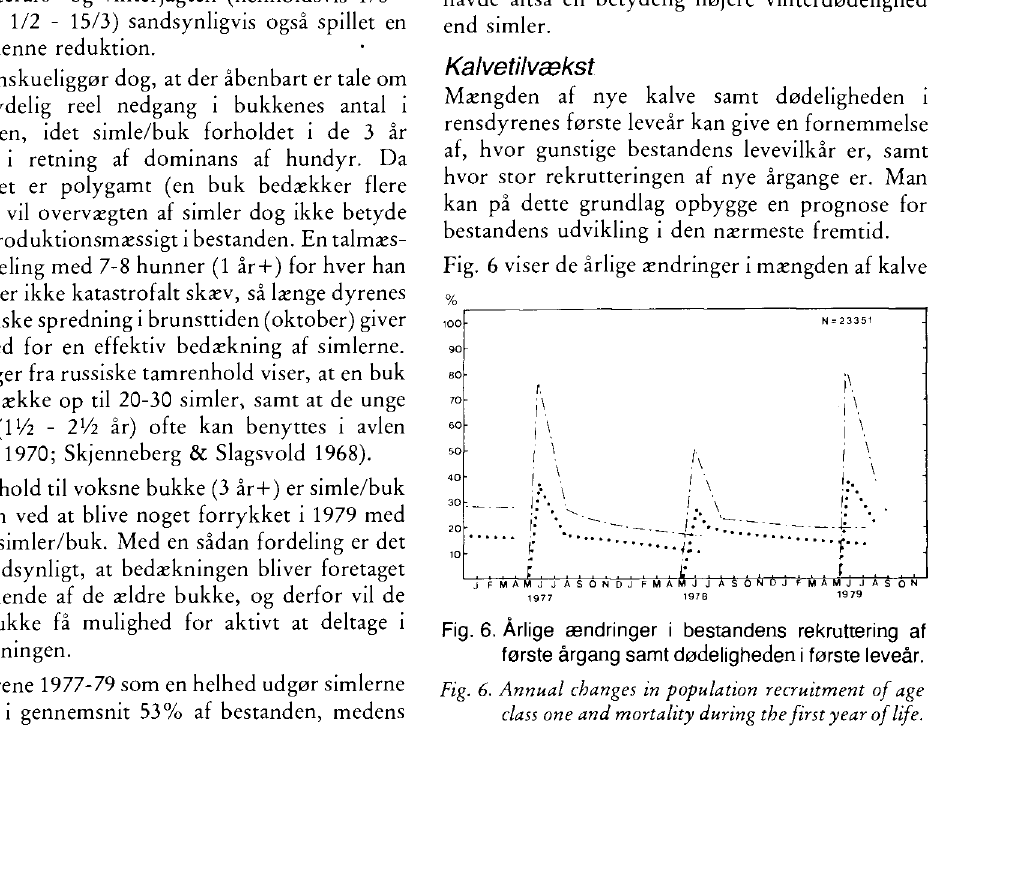
Fig. 5. Bestandens kønsfordeling (undtagen kalve) 1977—79. Fig. 5. Sex ratio in thepopulation (excl. calves) 1977—79.